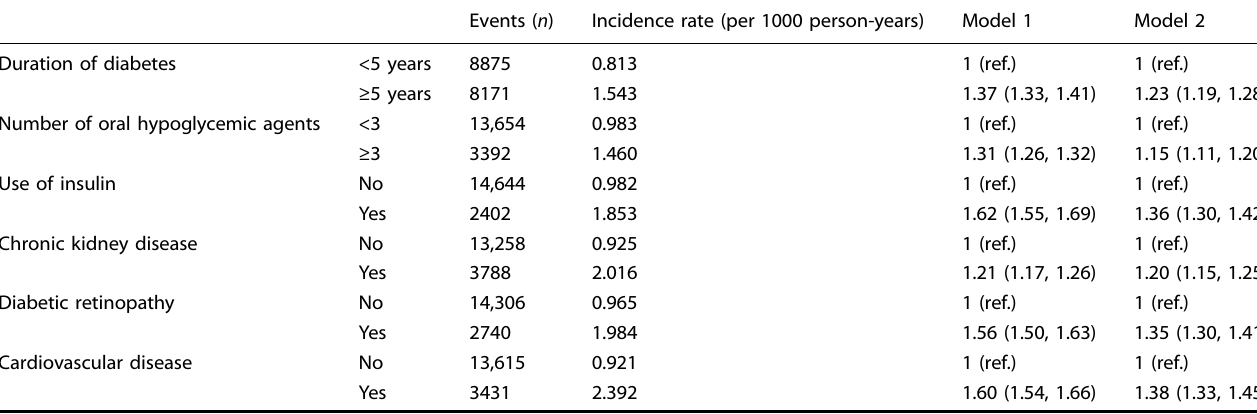
Table 2. The risk of Parkinson ’ s disease strati fi ed according to the diabetes severity